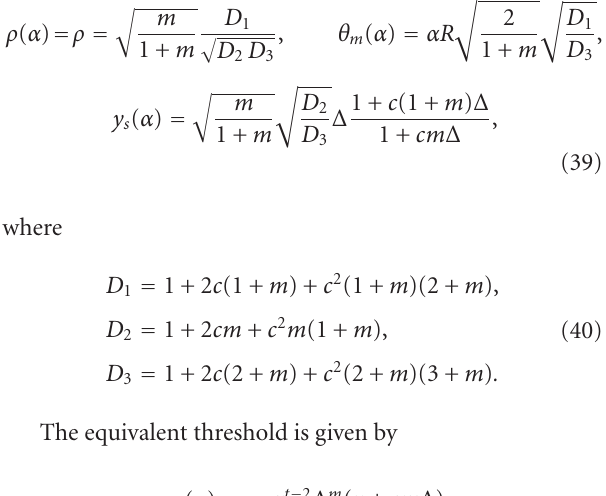
Table 1: Number density of detections n ∗ for the BSAF and the standard MF ( α = 1) with optimal values of c and α for di ff erent values of n ∗ R . RD means relative di ff erence in number densities in percentage: RD ≡ 100( − 1 + n ∗ b and